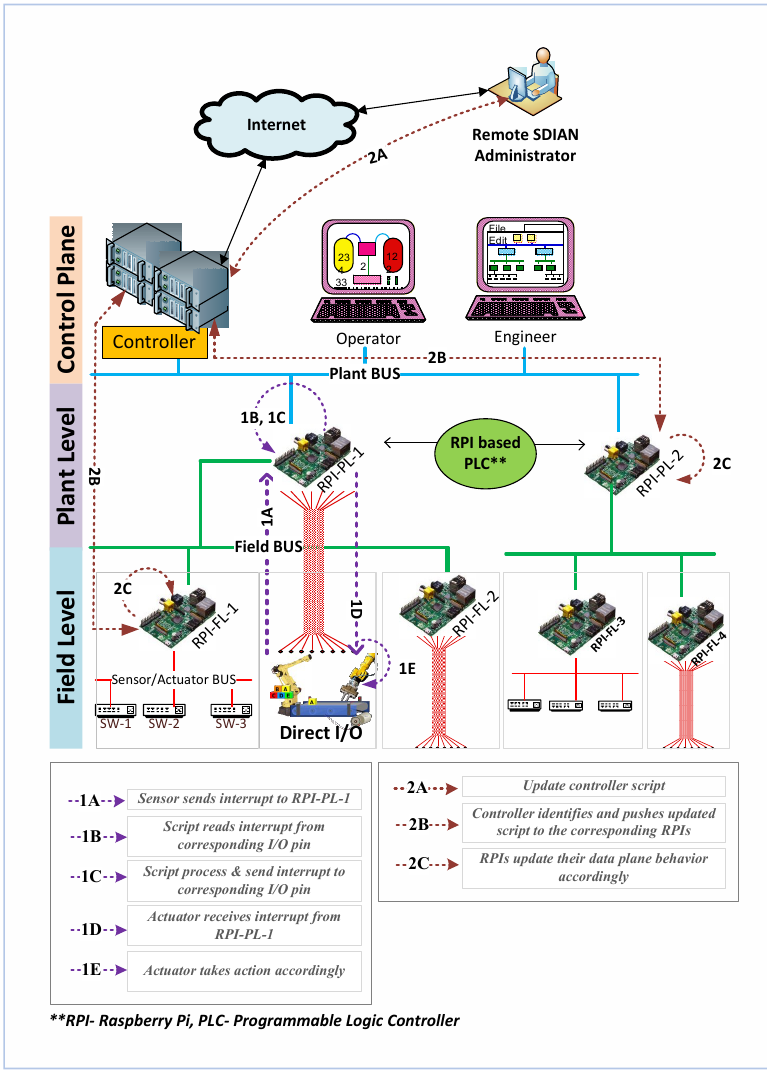
Figure 1. SDIAN (Software Defined Industrial Automation Network) conceptual architecture.